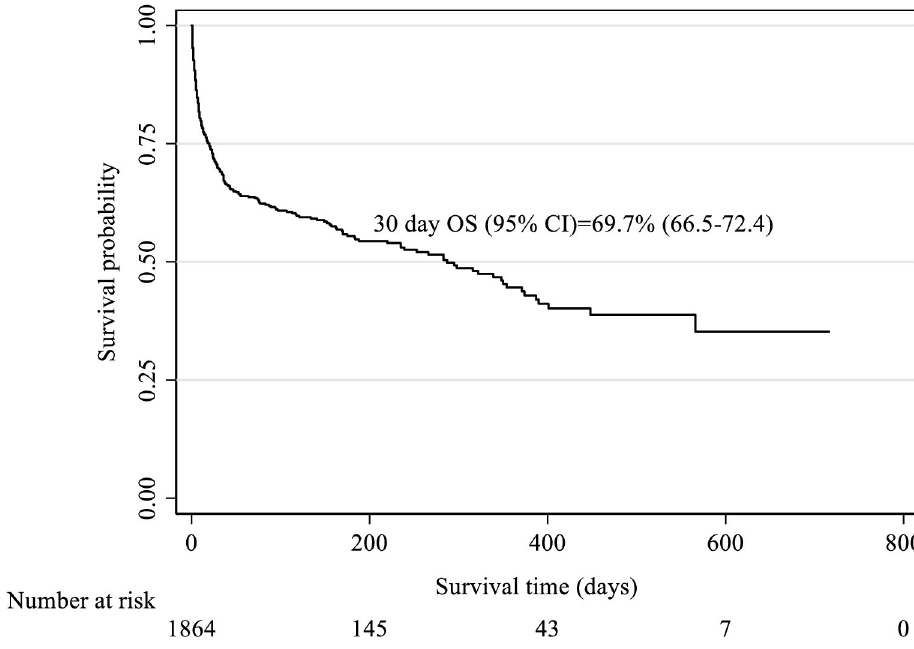
Fig 1. Kaplan-Meier survival estimate of transfused